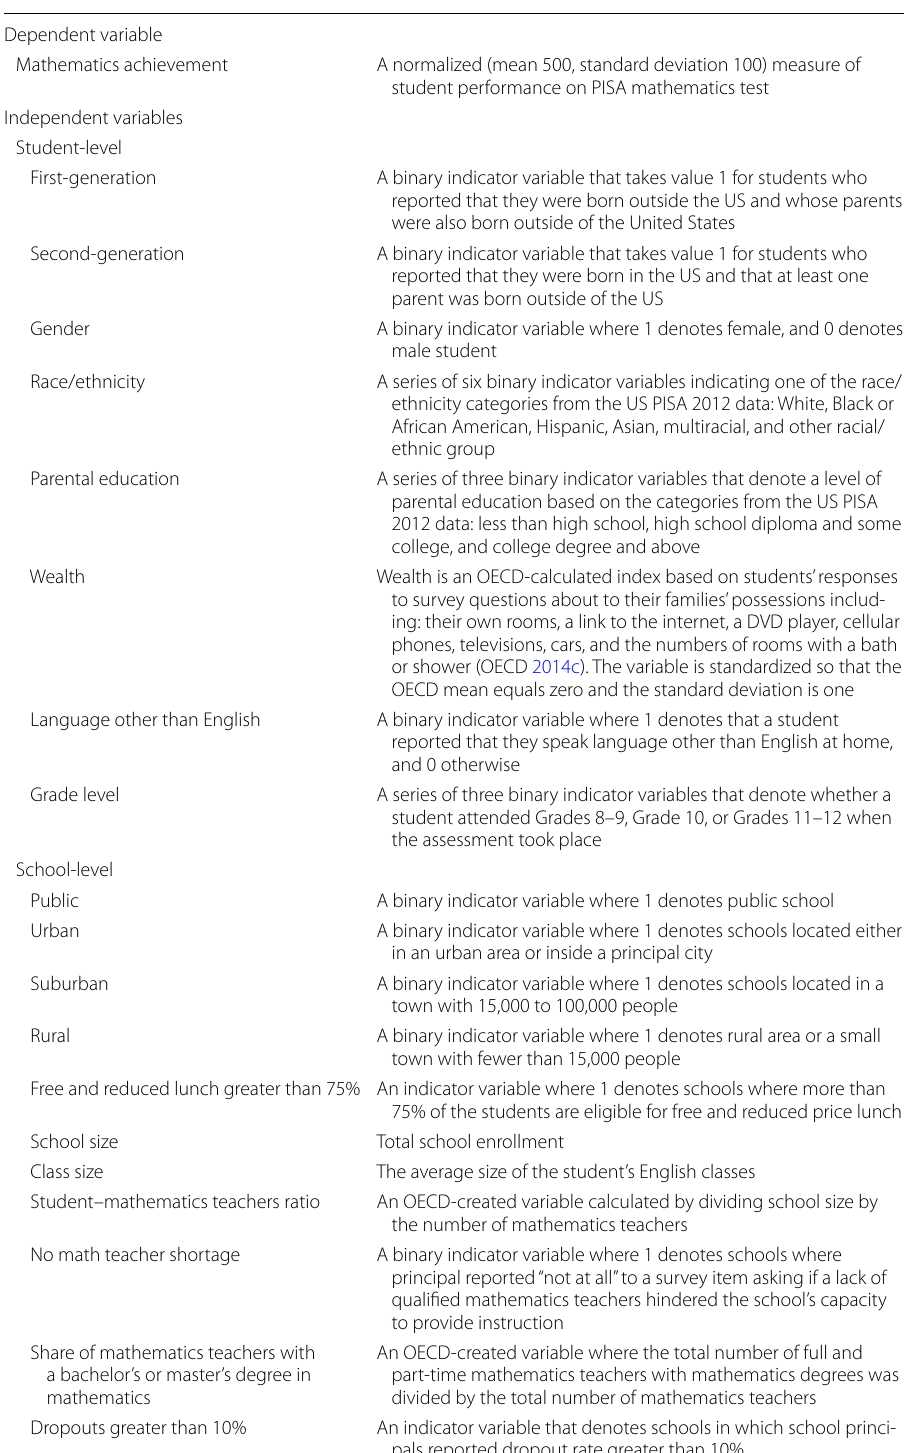
Table 1 Dependent and independent variables used in the analysis